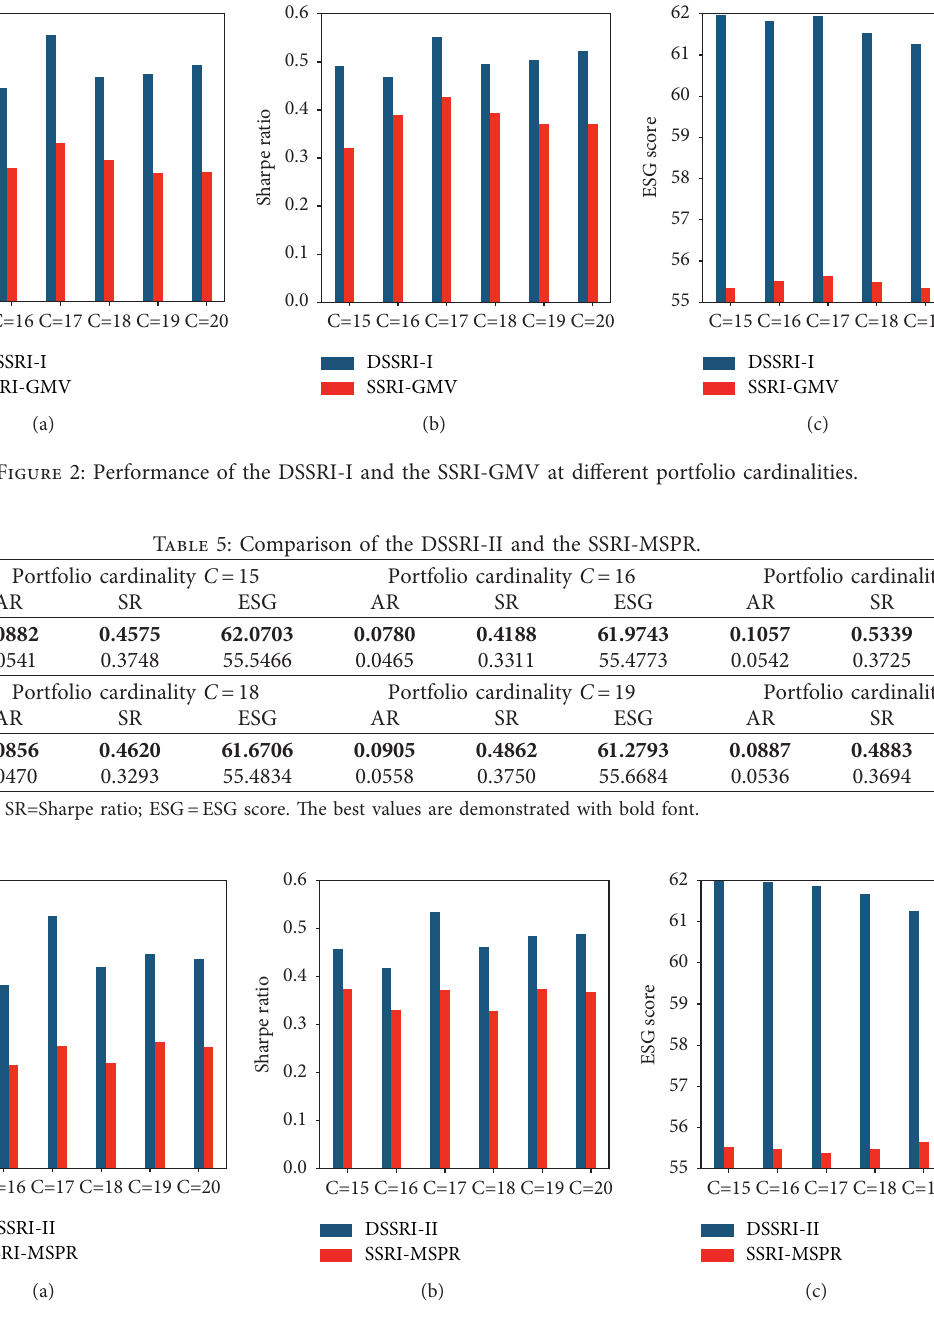
Figure 3: Performance of the DSSRI-II and the SSRI-MSPR at different portfolio